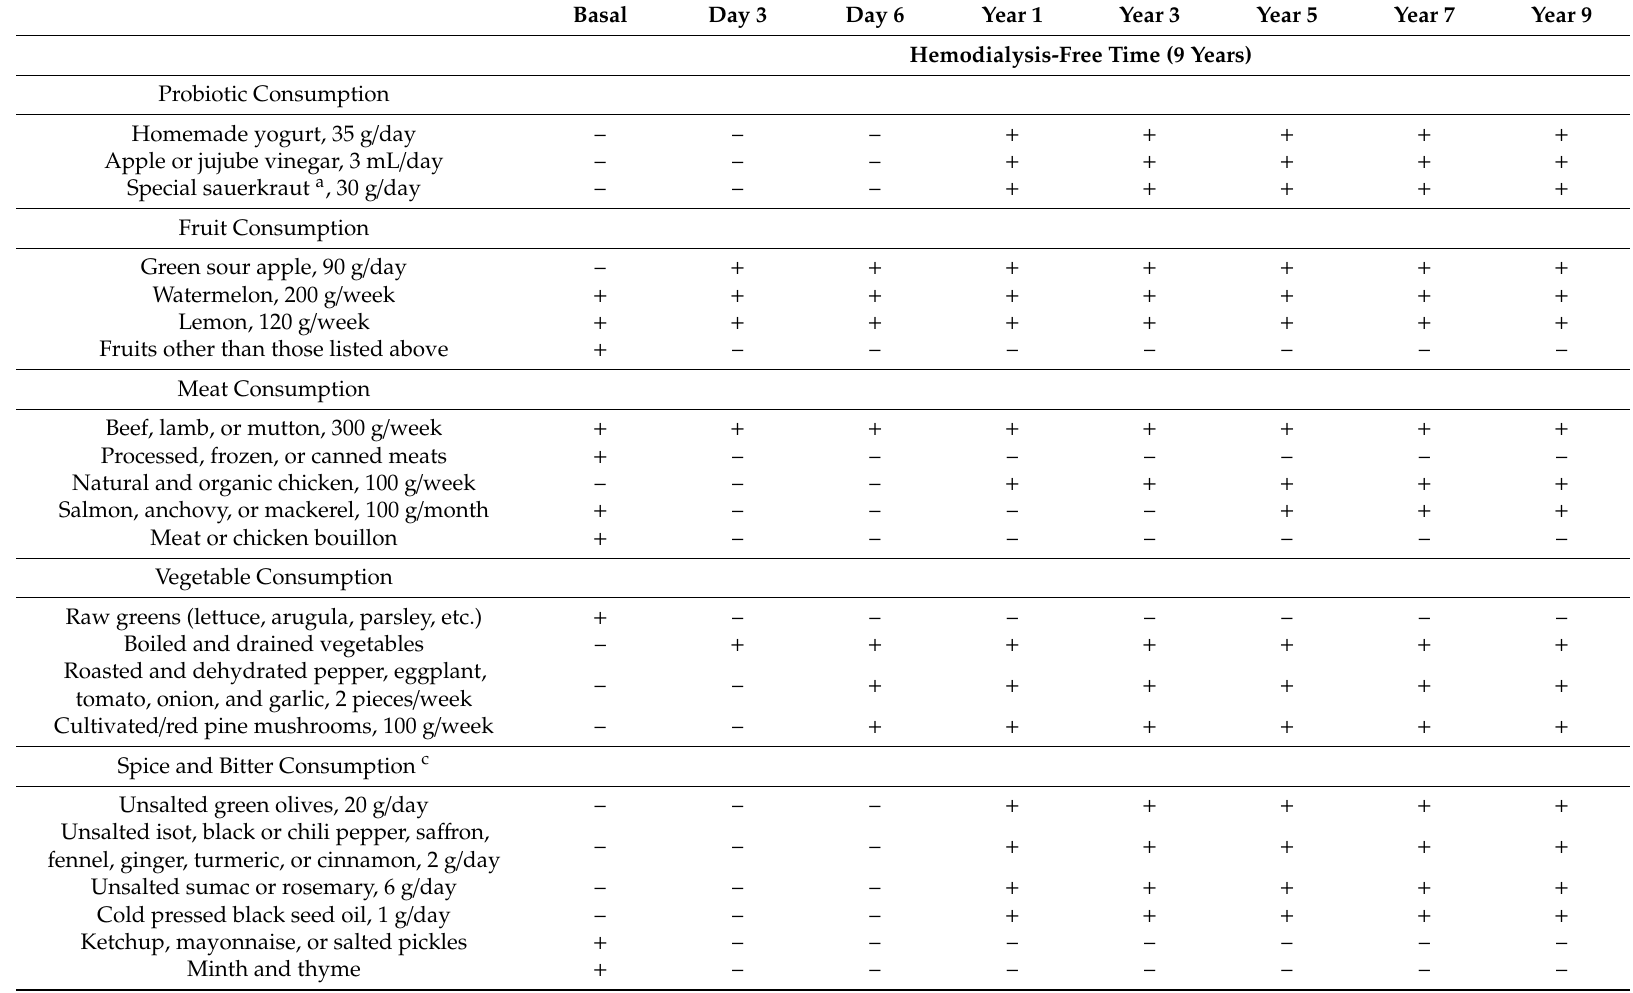
Table 3. Eating and drinking habits of the patient secondary to patient